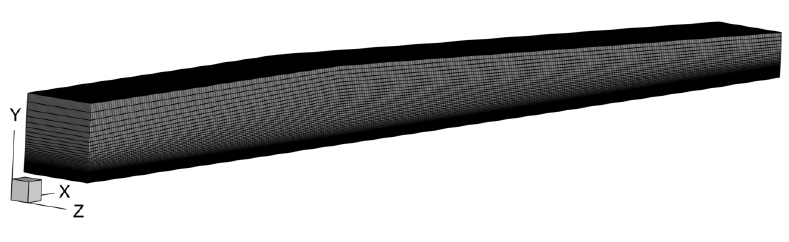
Figure 4. Schematic of the mesh in FPG